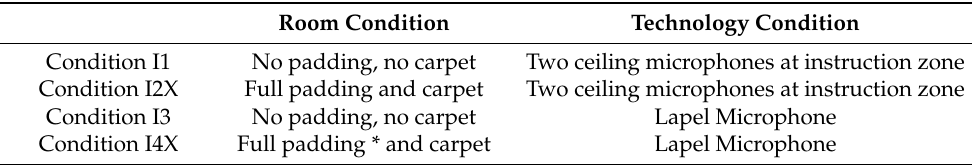
Table 1. Instruction conditions